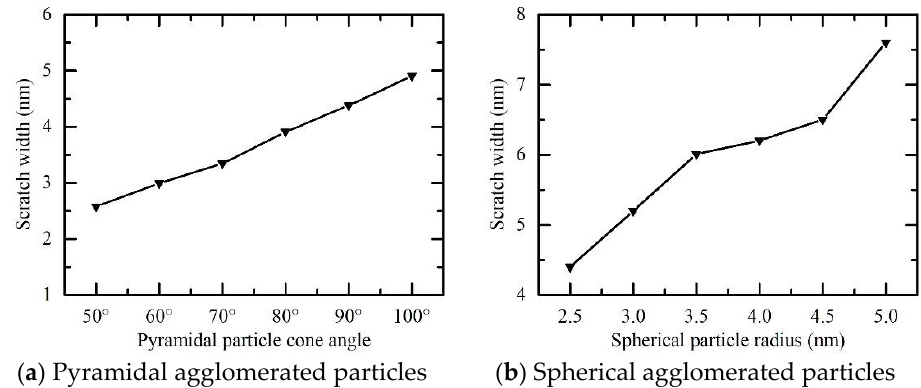
Figure 9. The actual scratch width with agglomerated particles of different shapes and sizes. Scratch depth was calculated based on simulation data using MATLAB. Figure 10 shows the relationship between scratch depth and the shape and size of the agglomerated particles. Here, the scratch depth formed by pyramidal agglomerated particles with a cone angle of 50° – 80° was approximately equal to the scratch depth formed by spherical ag- glomerated particles with a particle size of 2.5 – 3.5 nm. However, with a continuous in- crease in cone angle or particle size, the actual scratch depth decreased, which was mainly